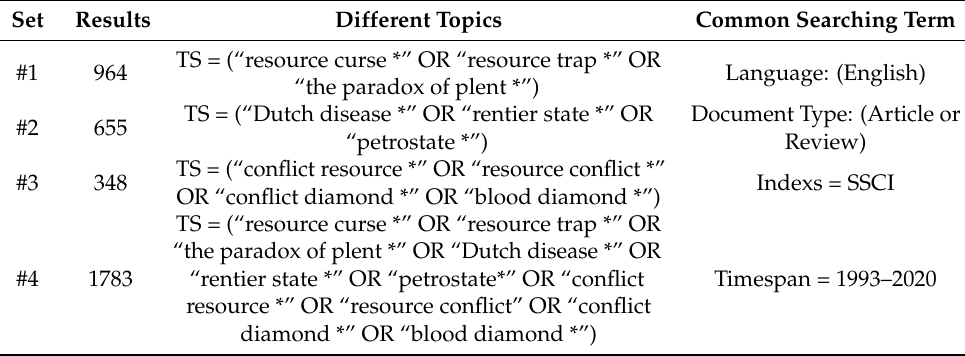
Table 1. Results from a selection of search